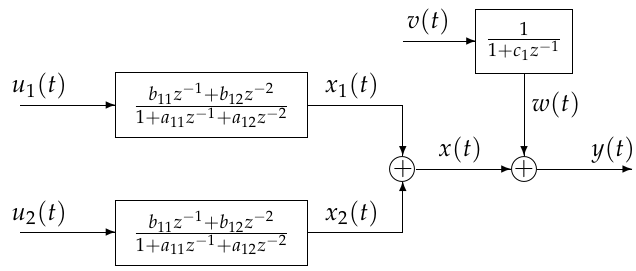
Figure 2. The diagram of a multi-input OEAR system. Table 5. The F-RGLS parameter estimates and errors for Example 2.